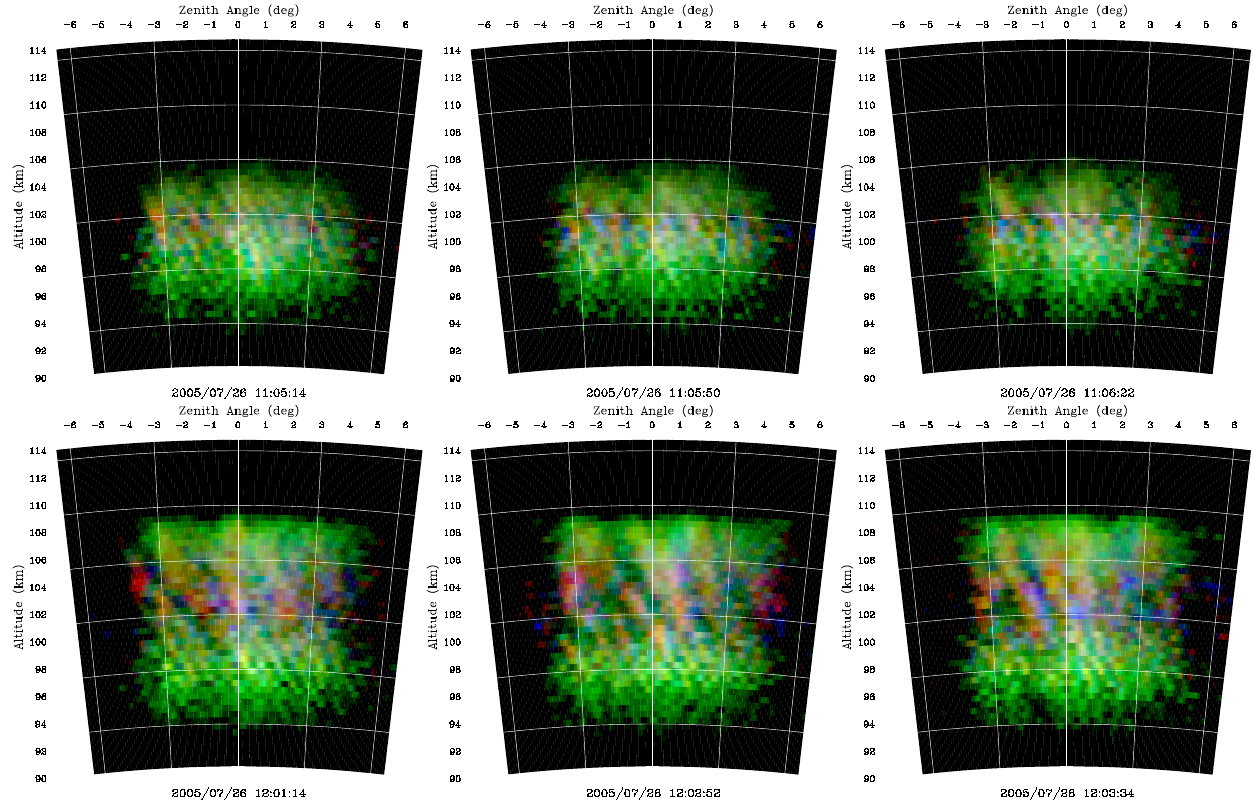
Fig. 3. Radar images of large-scale electrojet waves. The brightness, hue, and saturation of the image pixels reflect the intensity, Doppler shift, and spectral width of the corresponding echoes. The top (bottom) row of images correspond to times shortly after 11:00 LT (12:00 LT). The two-way antenna beam shape determines the field of view.